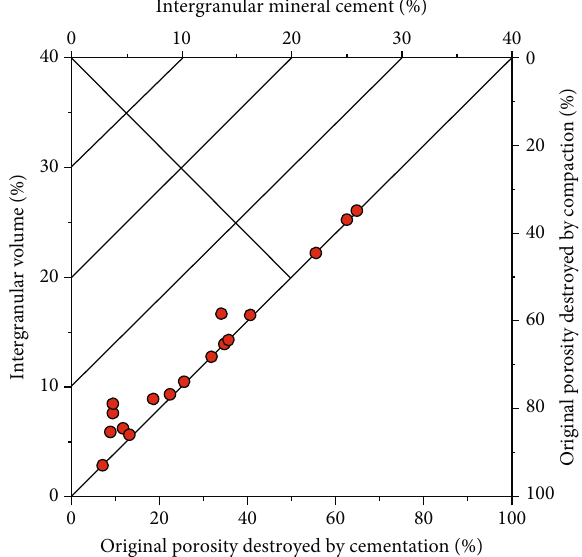
Figure 19: Diagram showing the compaction porosity loss versus cementation porosity loss in the sandstone reservoirs